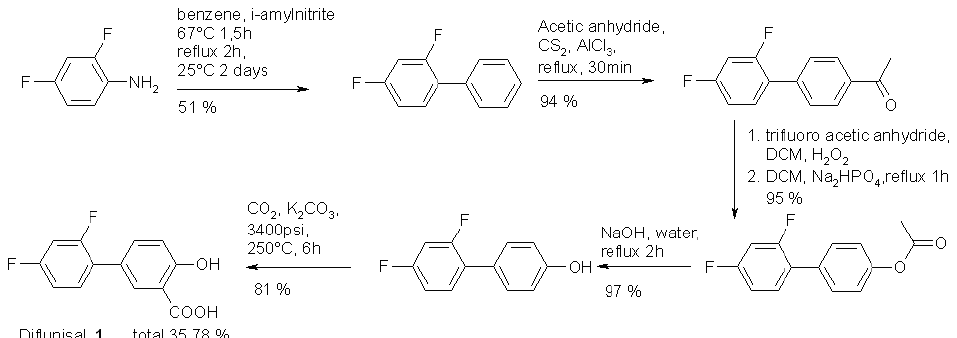
Scheme 1. Five step syntheses of Diflunisal by Hannah et